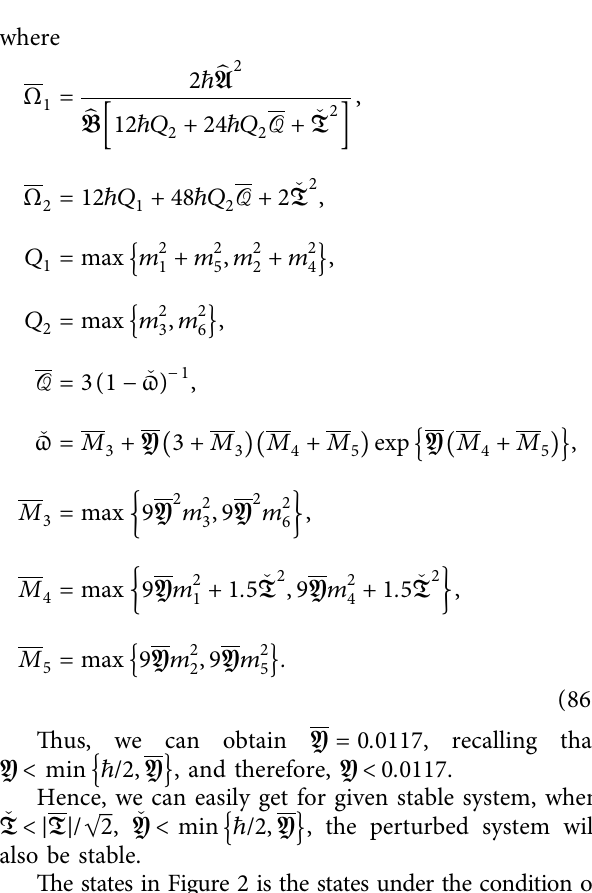
Figure 2: Te states of (81) with T � 0 . 002, Y 􏽮 􏽯 � 2 ξ + 1/70 in diferent initial values. Θ ξ